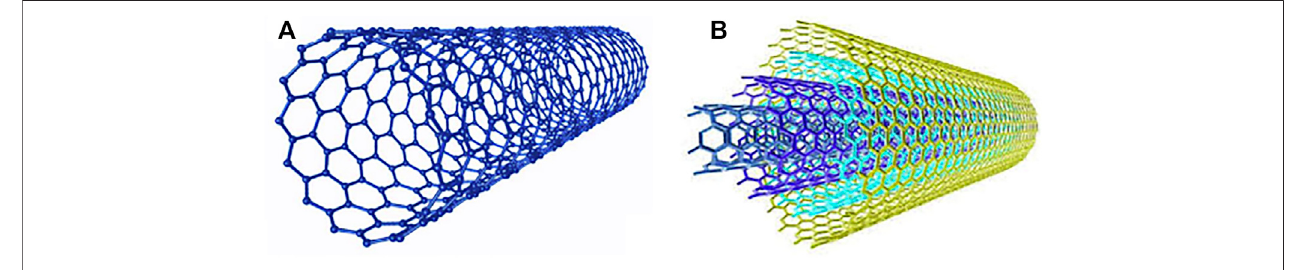
FIGURE 2 | The structure of (A) SWCNTs and (B) MWCNTs. Adapted with permission (Ouyang, 2019). Copyright 2019, Nano Materials